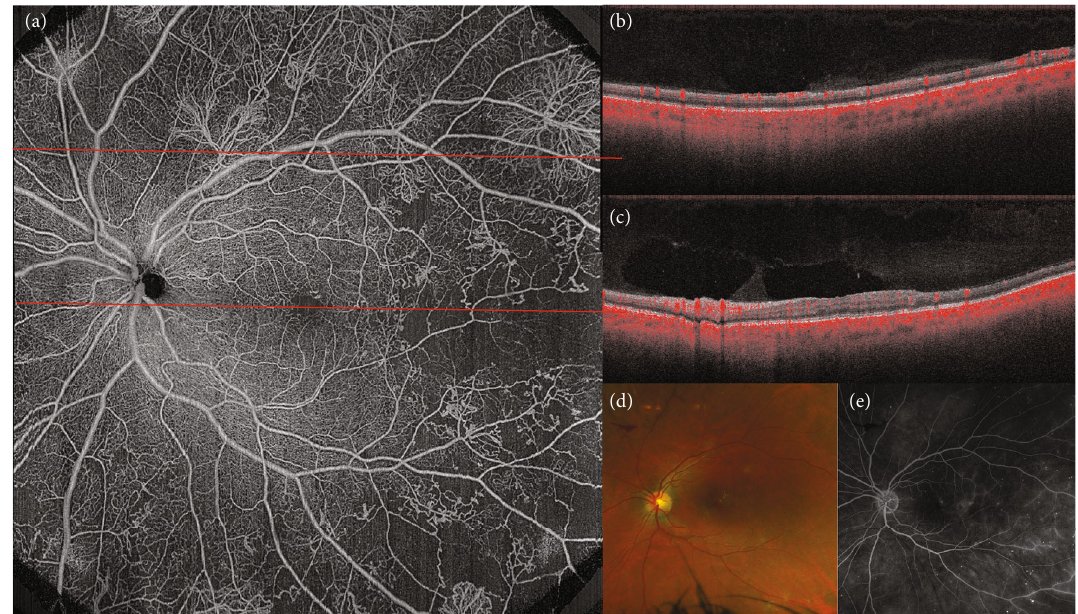
Figure 2: Multimodal imaging of proliferative diabetic retinopathy (PDR). (a) Wide fi eld optical coherence tomography angiography (WF- OCTA) of the posterior pole, revealing multiple neovascularization elsewhere (NVEs) and capillary nonperfusion (NP) temporal to the macula. (b) Structural B-scan passing through the area corresponding to the upper red dashed line. Temporally, NVE is discernible on the B-scan. (c) Structural B-scan passing through the fovea, corresponding to the lower red dashed line and showing temporal retinal thinning secondary to retinal ischemia. (d) Color fundus picture of the same patient, revealing macular exudates, cotton wool spots, and preretinal hemorrhages. (e) Fundus fl uorescein angiography shows microaneurysms, capillary nonperfusion, and